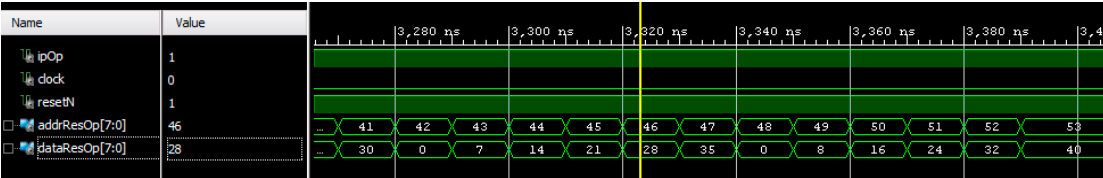
Figure 11. Simulation study results: Outer product (final set of results read-out only).